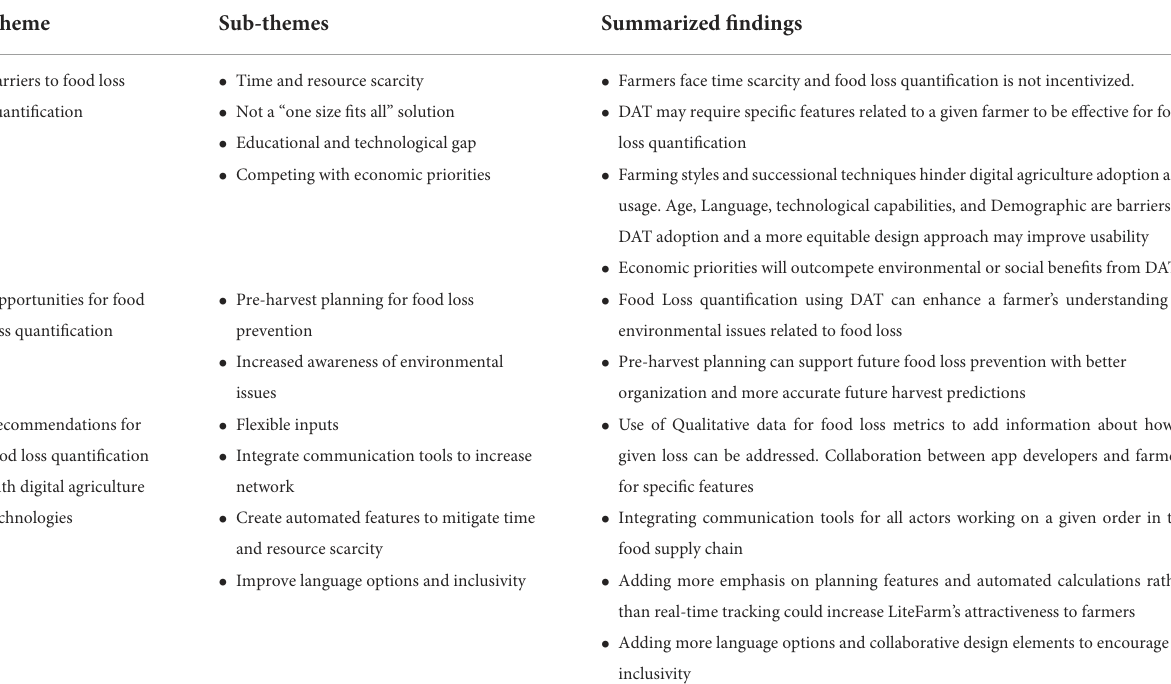
TABLE 2 Findings summary